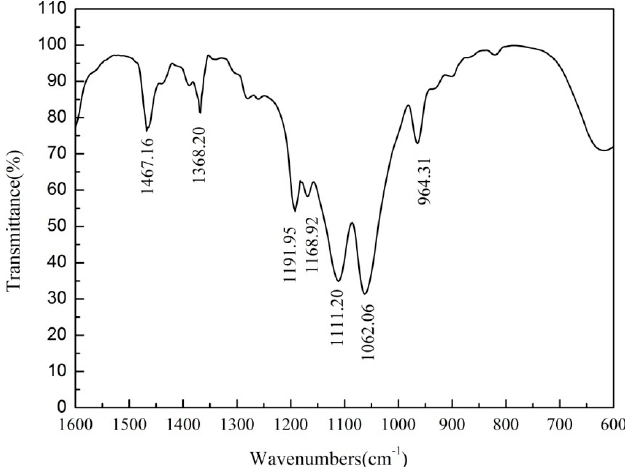
Figure 9. FTIR spectrum of sodium butyl xanthate.